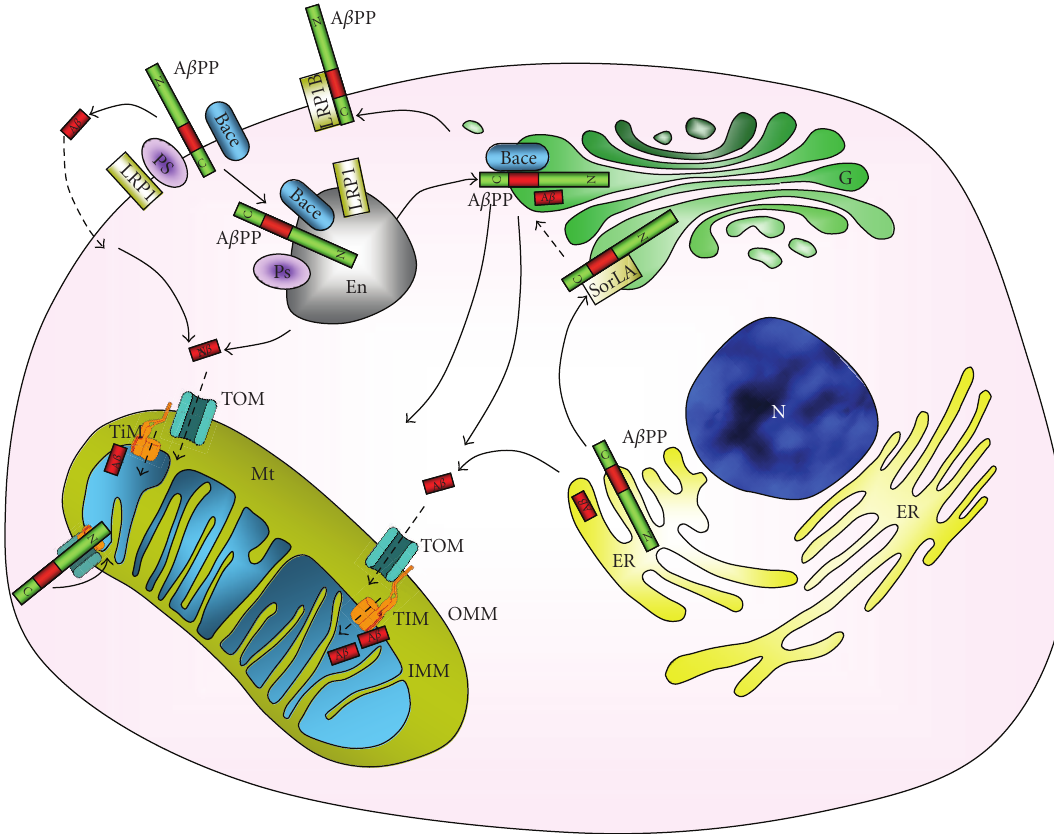
Figure 1: Intracellular localization of A β PP and A β . A β PP is synthesised in the endoplasmic reticulum (ER) and is tra ffi cked through Golgi network (G), to the cell surface or to mitochondria (Mt). In the plasma membrane the apolipoprotein (Apo) receptor LRP1 forms a complex with A β PP, inducing the internalization of the amyloid precursor protein, together with other plasma membrane enzymes, such as the β -secretase BACE and the γ -secretase presenilin (PS): A β is produced through amyloidogenic cleavage of A β PP. The plasma membrane complex A β PP with another Apo receptor, LRP1B, decreases the cellular uptake of A β PP. Sources of mitochondrial A β are the endosome (En) but also G and ER. G production of A β is decreased by binding of A β PP to another Apo receptor SorLA that blocks A β PP in the early G, counteracting A β PP cleavage pathways. A β enters into the mitochondrial matrix through TOM and translocase of the inner membrane (TIM) or is derived from mitochondria-associated A β PP metabolism. N = nucleus, OMM = outer mitochondrial membrane, IMM = inner mitochondrial